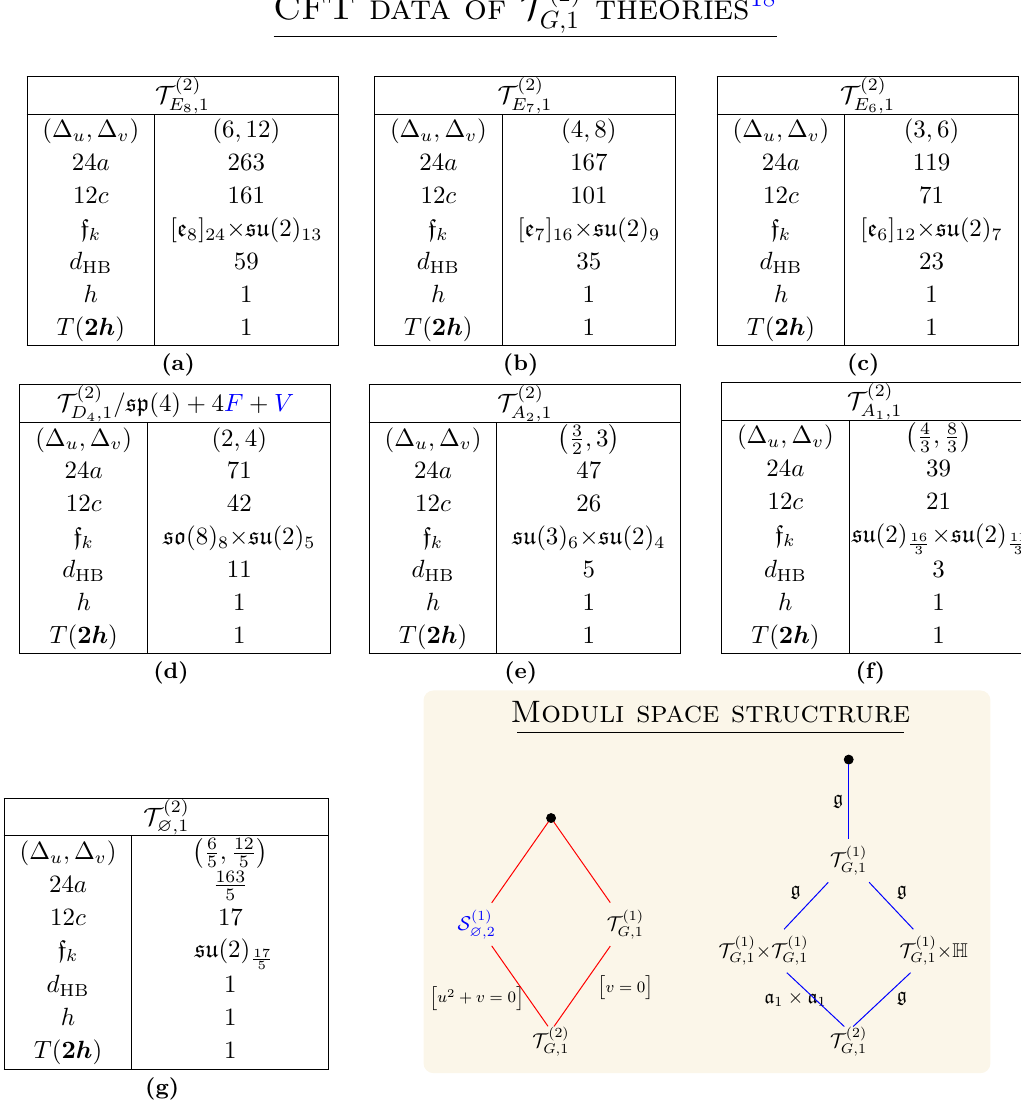
Figure 45. In this figure we report the relevant CFT data for the T (2)